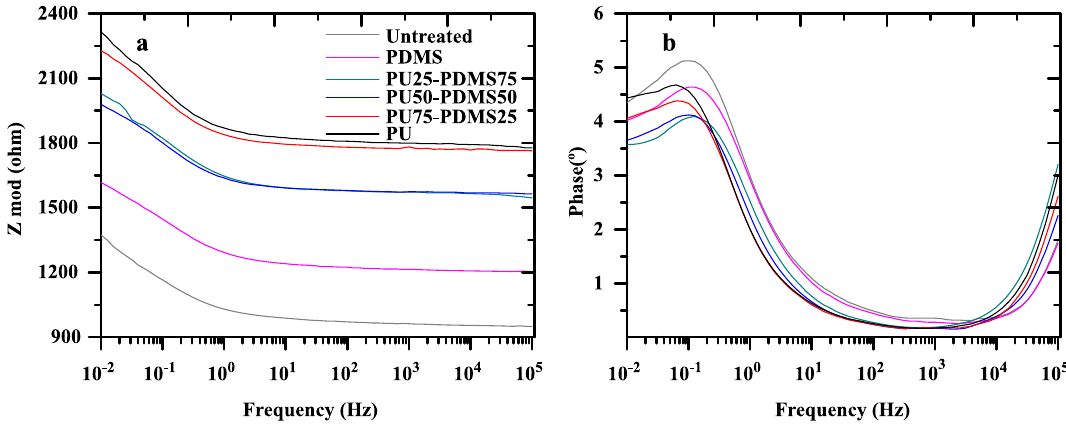
Figure 9: Bode plots for AISI 316 coated with PU – PDMS polymers in Ringer ’ s solution: ( a ) Bode magnitude and ( b ) Bode phase.